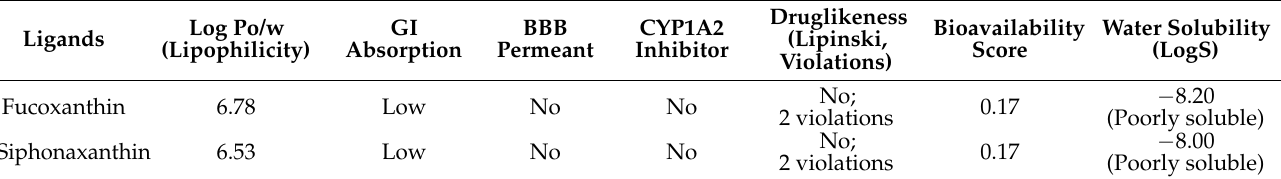
Table 3. Pharmacokinetic parameters of compounds by SwissADME in